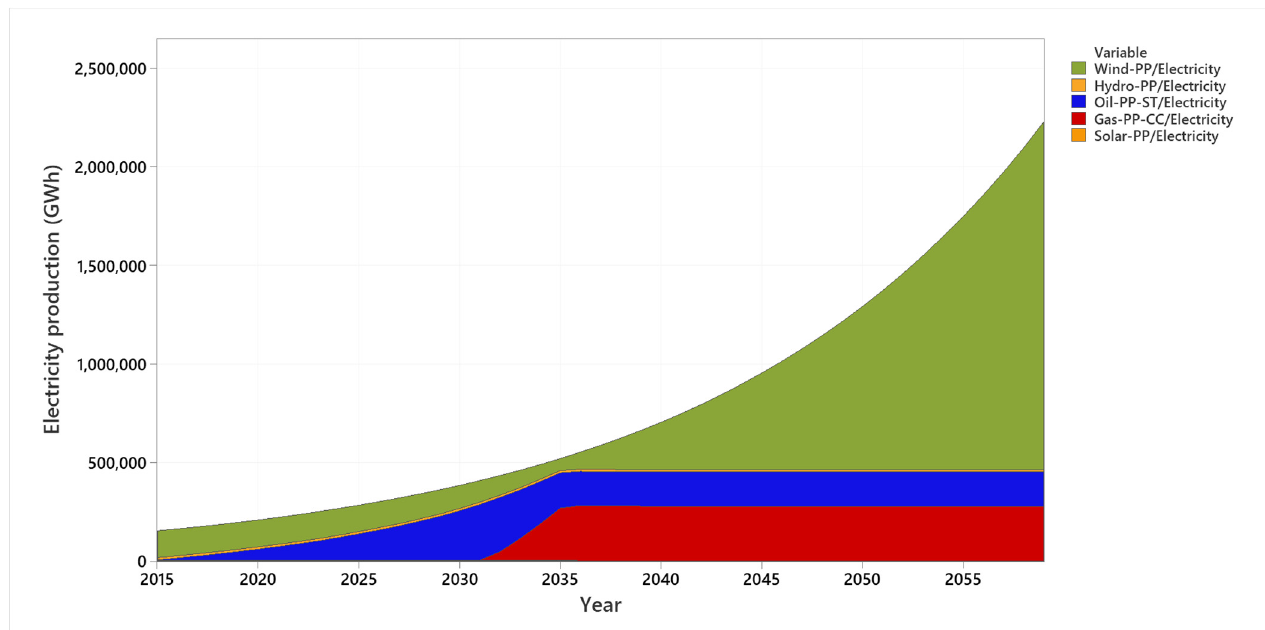
Figure 10. Balance of electricity production of all power plants for fifth scenario, wind case.